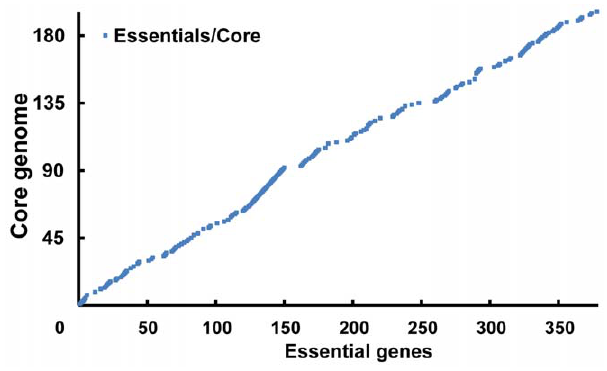
Figure 6. Similarity relationship between core and essential genes. Genes on x-axis represent the essential genes documented in M. genitalium G37, while genes on y-axis represent the core genome identified in this study. Both the genes on x-axis and y-axis are distributed in terms of genomic coordinates. On-diagonal, genes that are both essentials and core are indicated as a series of colored dots.